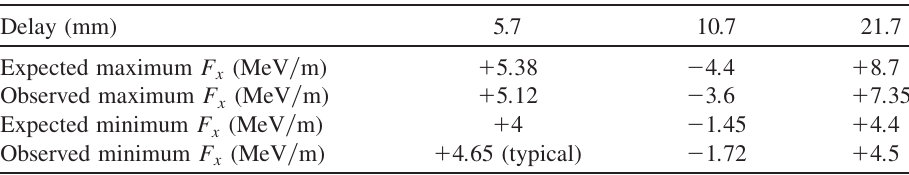
TABLE IV. Comparison of observed F x values with the model predictions.